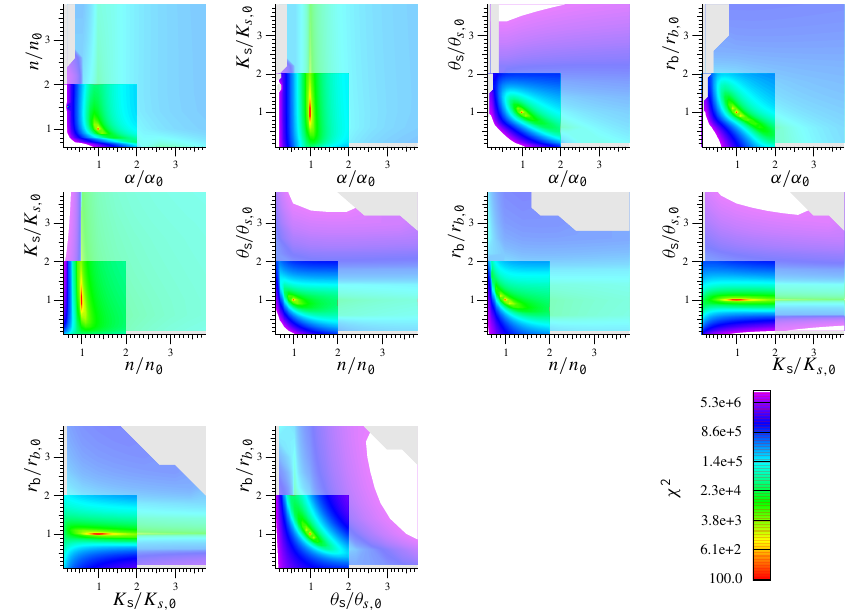
Fig. 12. Response surfaces for the threestep experiment with j w and ψ m as target variables. The light regions with deviation coefficients larger than 2 were calculated with a smaller resolution of 0.4. Non-matching structures between the two regions are caused by the different resolution. Note that a χ 2 above 10 7 is displayed in white, points where the model did not finish after 120000 time steps is marked grey. j w j w , ψ m j w , (cid:15) c (cid:15) c , ψ m